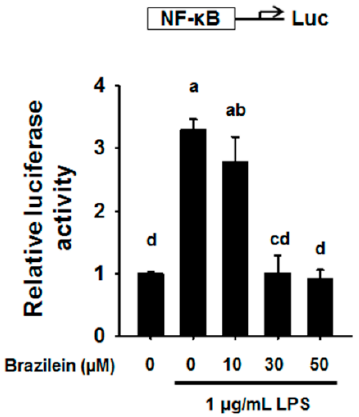
Figure 4. Brazilein attenuated the NF- κ B reporter activity in LPS-induced Raw264.7. Cells were pre-incubated with 10, 30, and 50 μ M brazilein for 1 h and then co-treated with 1 μ g/mL LPS for additional 10 h. DMSO was used as a vehicle. The data are expressed as mean ± standard deviations (SD), ( n = 3). Values with different letters are significantly different, p < 0.05.